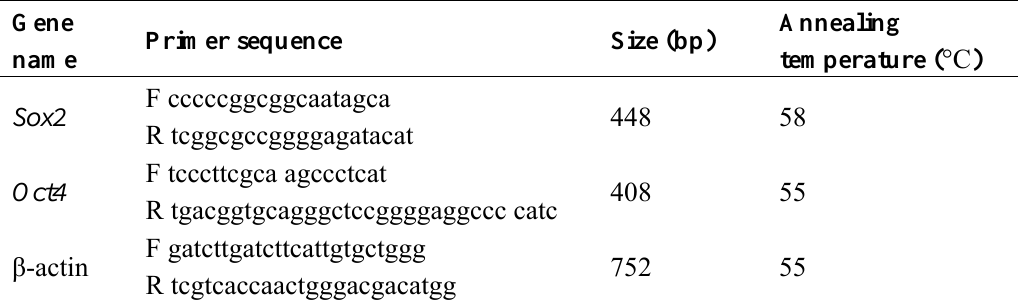
Table 4. Primers for Sox2 , Oct4 and β -actin